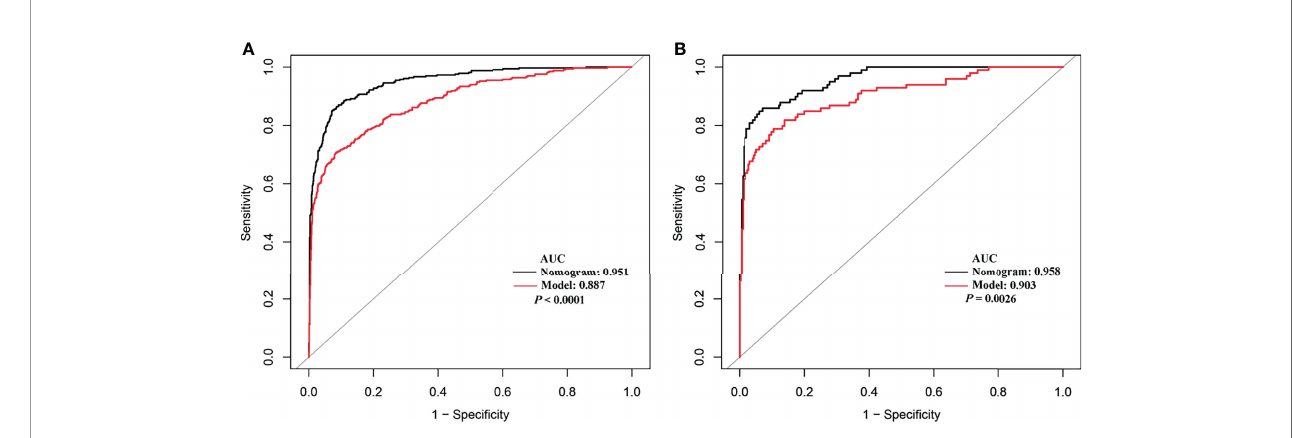
FIGURE 3 | The receiver operating characteristic curves of the nomogram and model from development cohort (A) and validation cohort (B) .